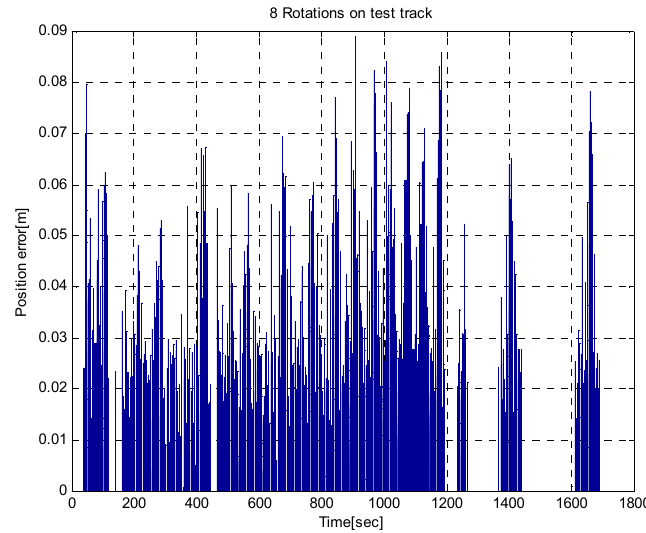
Figure 13. Position error based on the marker during eight test laps.